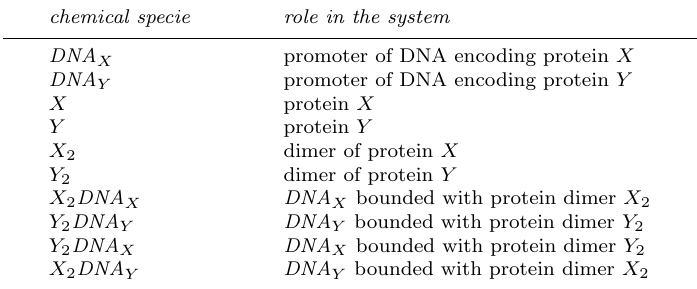
Table 1. Chemical species that are observed within the analyzed system. chemical specie